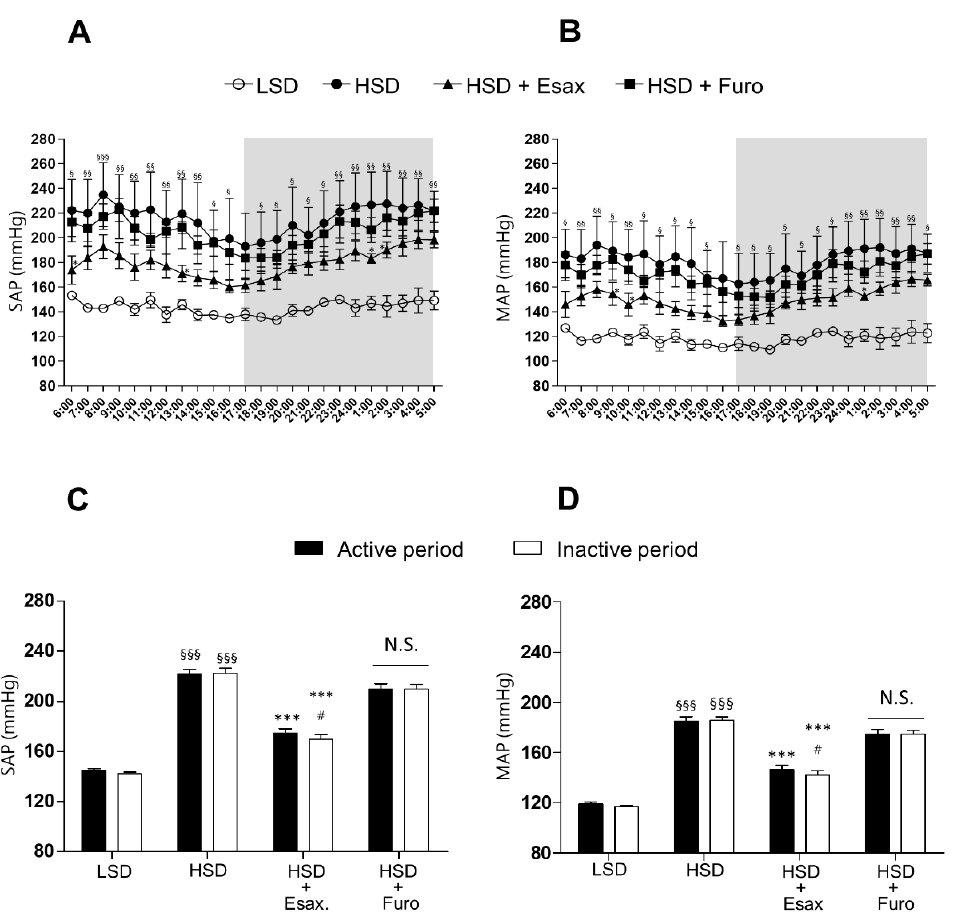
Figure 1. Changes in BP in HS-loaded DSS rats. Twenty-four-hour ( A ) SAP and ( B ) MAP measured by a radiotelemetry system in conscious rats after 4 weeks of treatment with an LSD ( n = 3), HSD ( n = 5), HSD plus esaxerenone ( n = 5), or HSD plus furosemide ( n = 5). Mean 12 h ( C ) SAP and ( D ) MAP in the active and inactive periods. § p < 0.05, §§ p < 0.01, §§§ p < 0.001 vs. LSD (in the active and inactive periods); * p < 0.05, *** p < 0.001 vs. HSD (in the active and inactive periods); # p < 0.05 vs. HSD plus